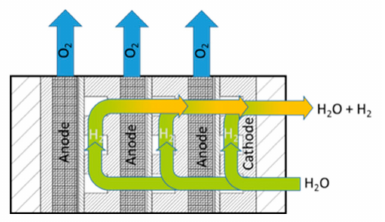
Figure 2. Setup of the electrolysis stack with cathodic media supply.